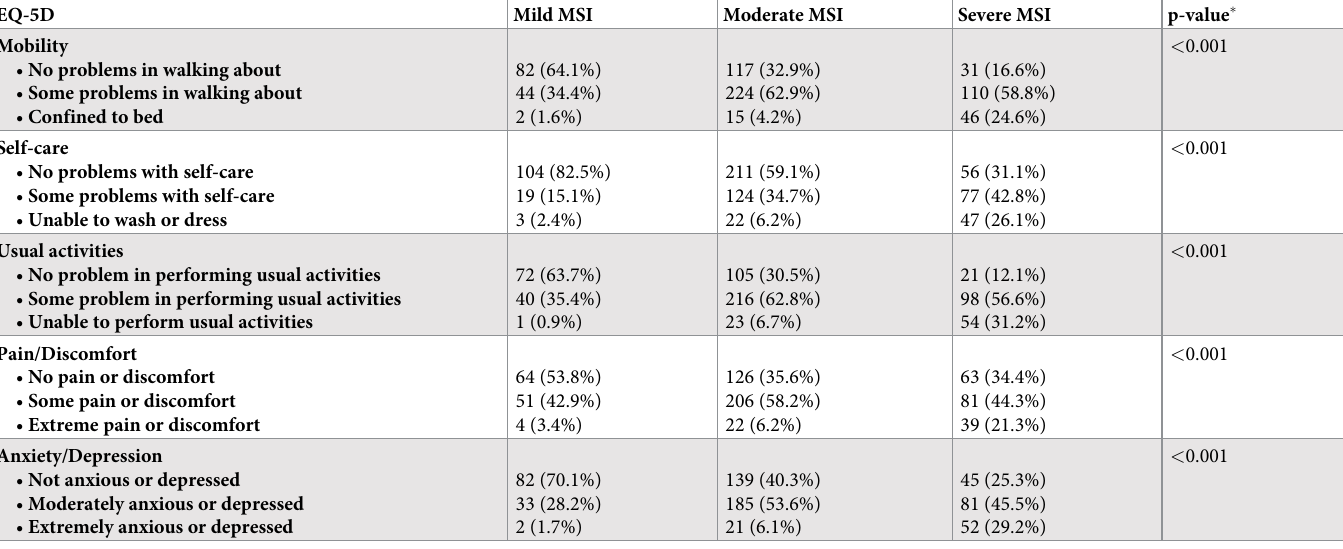
Table 6. Distribution of patients in each level of the 5 dimensions of EQ-5D-3L according to MSI severity level.